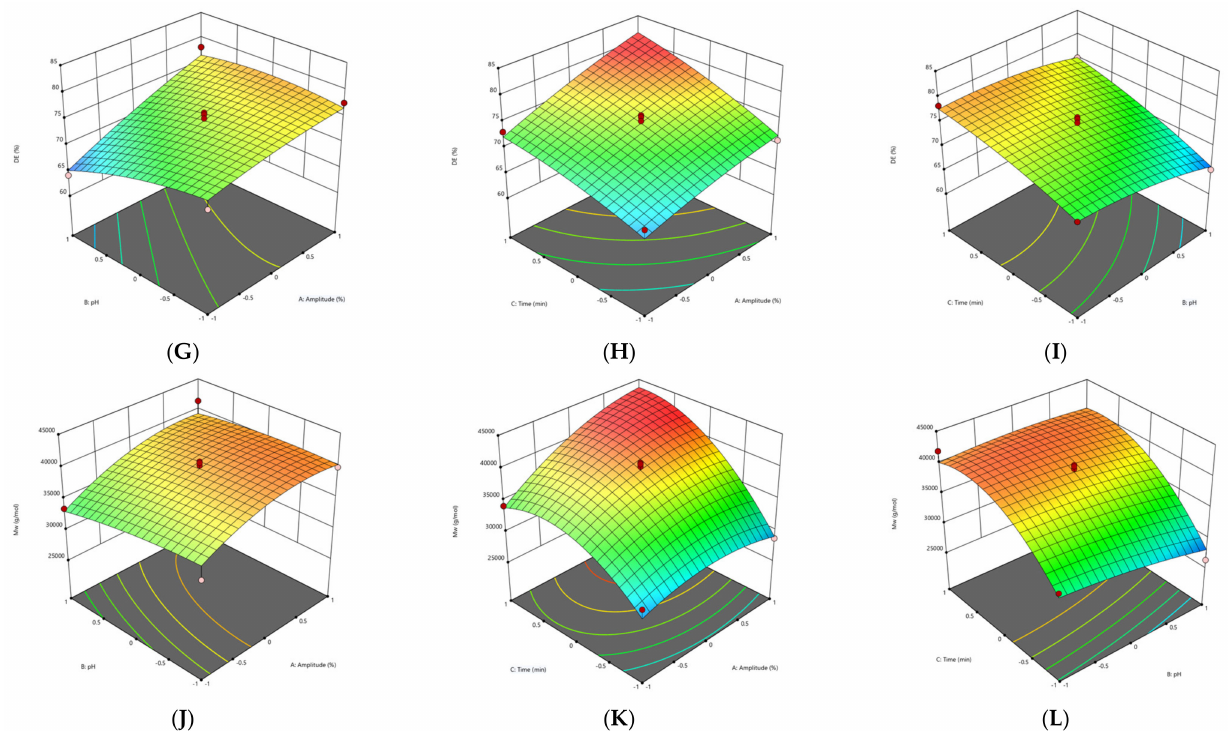
Figure 4. 3D graphs showing the influence of extraction parameters on the yield ( A – C ), GalA content ( D – F ), DE ( G – I ) and M w ( J – L ) for RN pectin extracted by